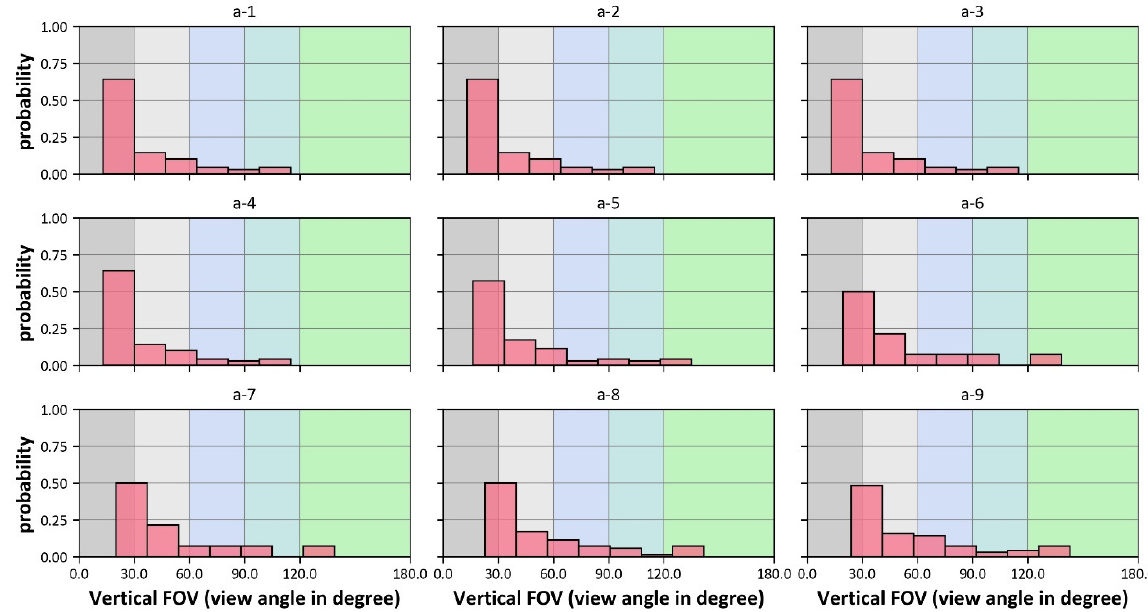
Figure A2. Histograms of the computed vertical FOVs for scenario-a, including case studies with different window sizes.